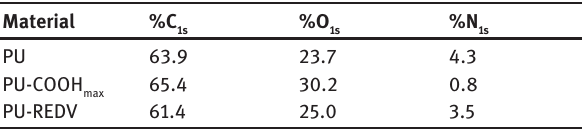
Table 1: Elemental composition for non-modified PU and PU after subsequent modification steps: AA grafting (PU-COOH peptide coupling (PU-REDV). Material PU-COOH max